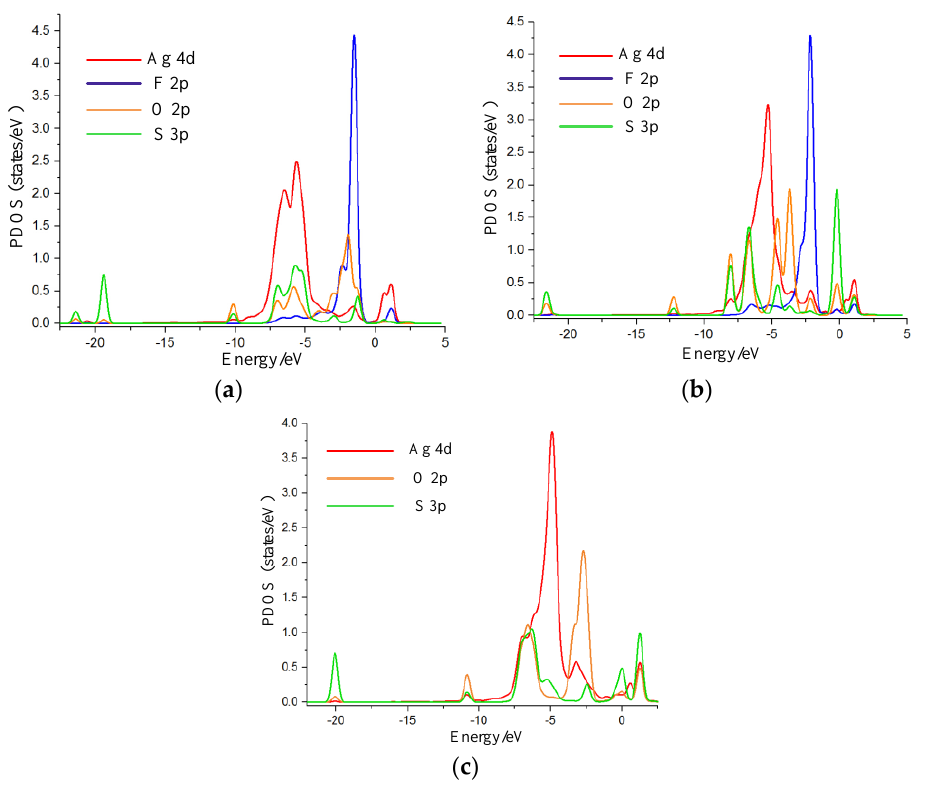
Figure 7. PDOS for Ag-graphene with and without single molecule adsorption; ( a ) PDOS for 4d of Ag atom, 3p of S atom, 2p of O atom, and 2p of F atom in SO 2 F 2 ; ( b ) PDOS for 4d of Ag atom, 3p and 3d of S atom, and 2p of F atom in SOF 2 ; and ( c ) PDOS for 3p of S atom and 2p of O in SO 2 .